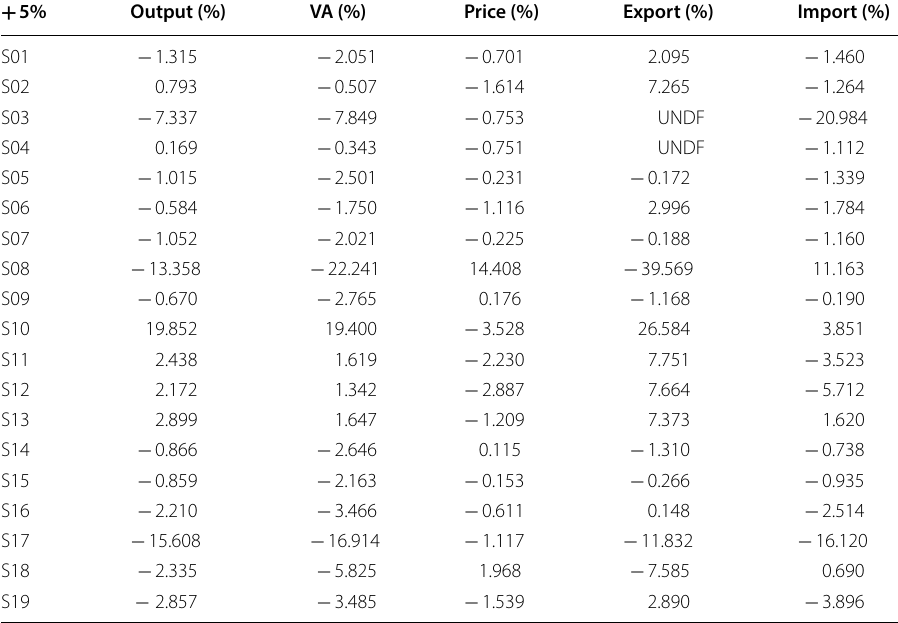
Table 7 The effects of a 15% increase in crude oil domestic